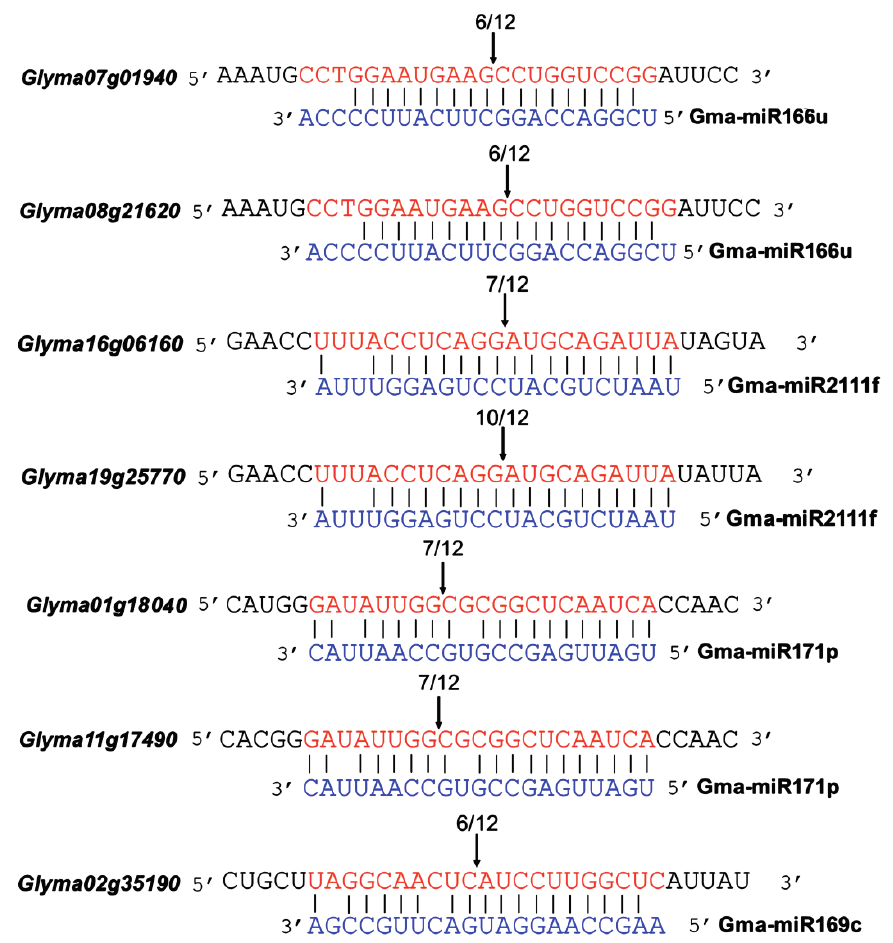
Figure 3. Validation of the miRNA-directed cleavage of the putative target genes using rapid amplification of 5' complementary DNA ends (5'-RACE). The predicted targets of gma-miR171p , gma-miR166u , gma-miR2111f and gma-miR169c were experimentally validated. The mRNA cleavage sites were determined by modified 5' RNA ligase-mediated (5'-RLM)-RACE. The mRNA sequence of each complementary site and its 5' and 3' flanking sequences (5 nucleotides (nt) from 5' to 3') and cloned miRNA sequence (from 3' to 5') are shown. Vertical arrows indicate the 5' termini of the miRNA-guided cleavage products, as identified by 5'-RACE, with the frequency of clones